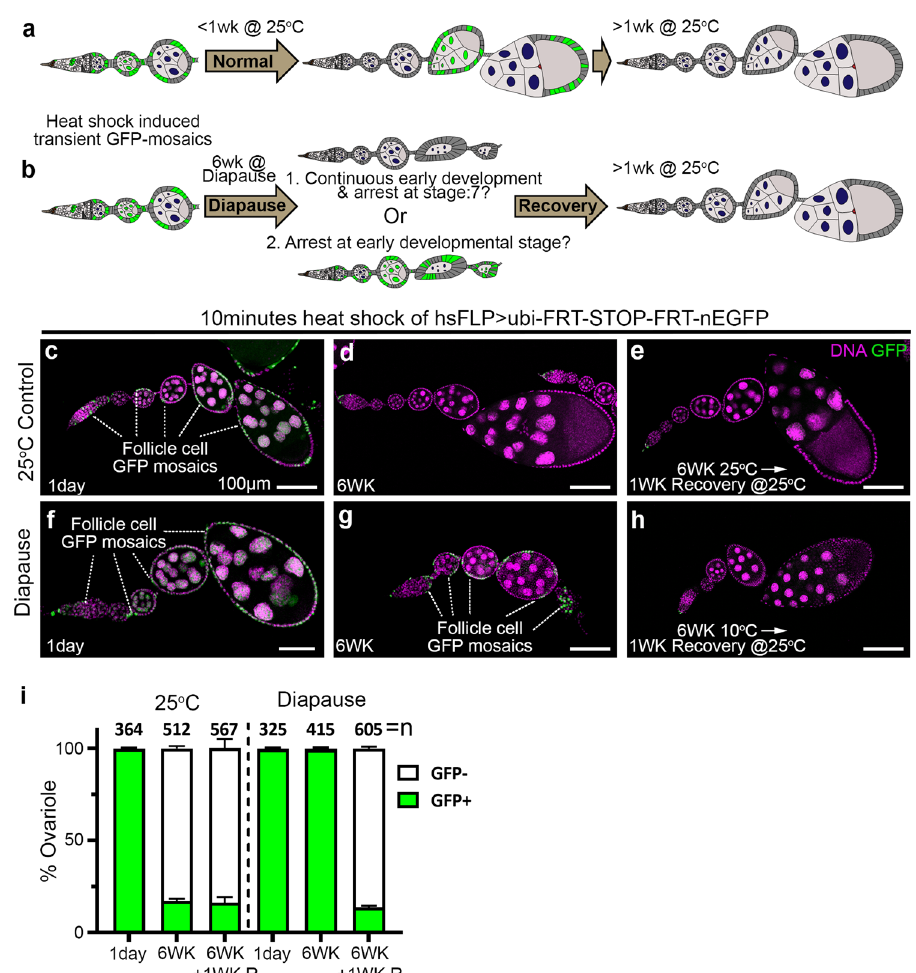
Fig. 2 Diapause arrest at multiple stages. a , b Schematic representation of the experimental design. Transient, GFP + clones are generated by heat shock (see methods for details). a As egg chambers develop, those containing GFP + cells mature into eggs that are laid, and are replaced by unlabeled egg chambers. b In diapause, if egg chambers are continually produced and degenerating (option 1, top), GFP labeling would be lost, but if egg chamber development stops (option 2, bottom), degenerating GFP-labeled egg chambers would persist. In either case, upon transfer to recovery conditions, development should resume and GFP labeling should disappear. c – e Controls showing the presence of transient GFP clones 1 day after heat shock ( c ) and loss thereafter ( d , e ). f – h In diapause, GFP-labeled egg chambers persist for six weeks and are lost after a week of recovery. Scale bars 100 µ m. i Quanti fi cation of the percentage of ovarioles containing any egg chamber younger than stage 14 with GFP + cells, comparing normal aging to diapause and recovery. The data shown are from three independent experiments. Error bars = mean±s.e.m. n is the total number of ovarioles analyzed. See also Supplementary Fig.